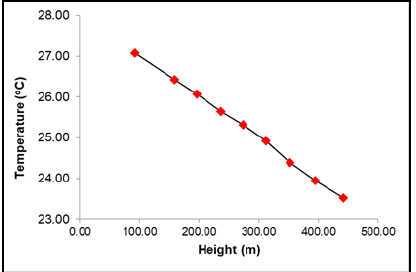
Table 4. Pearson correlation coefficient between independent and dependent variable for different height intervals absolute value in the flight).